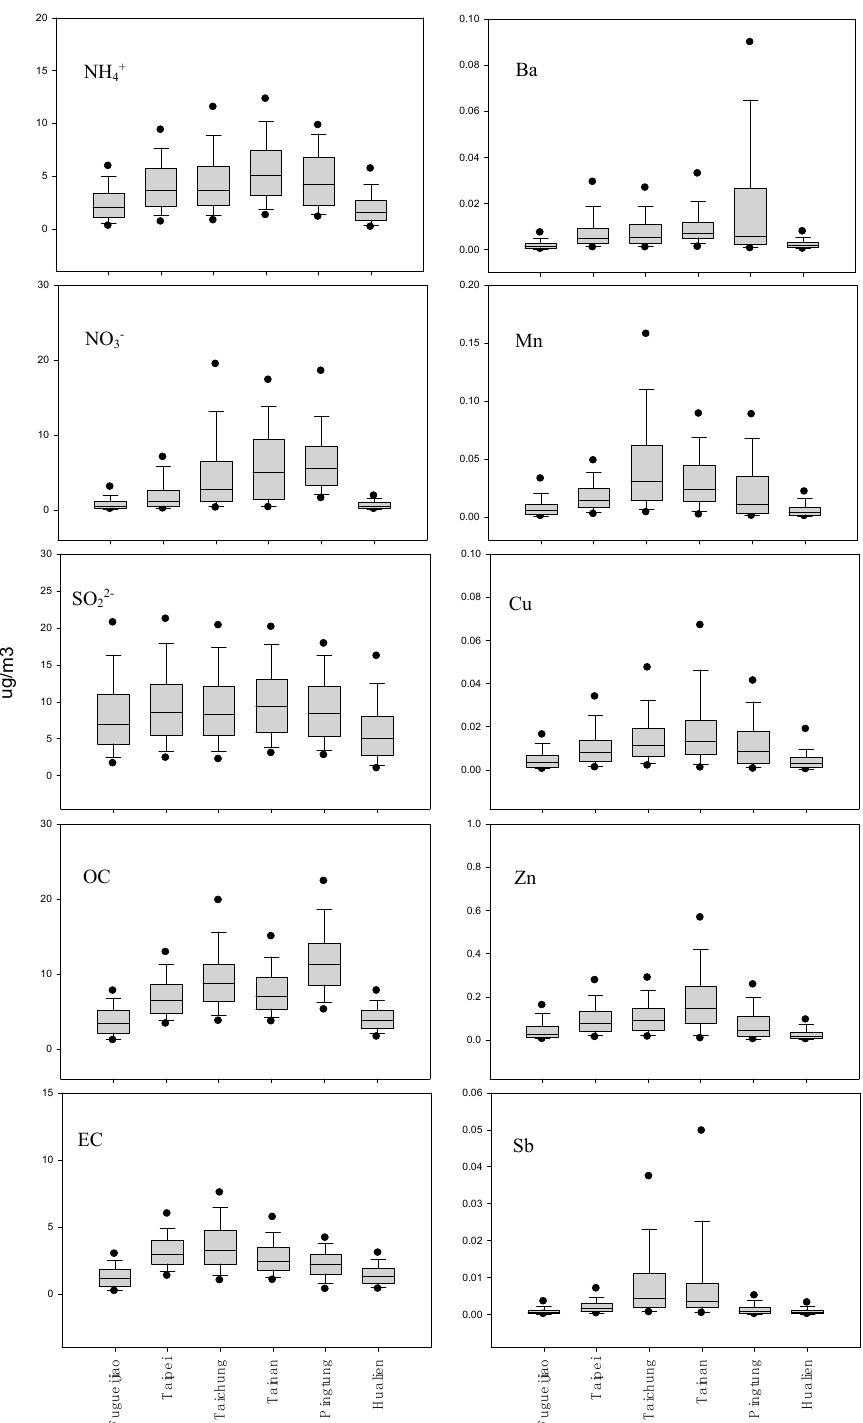
Figure 2. Box plots of the PM 2.5 -bound compounds in six study areas, including 5 and 95 percentiles (black dot), 25 and 75 percentiles respectively subtracted and added by inter-quartile range (lines outside the box), and 25 percentile, median and 75 percentile (box).